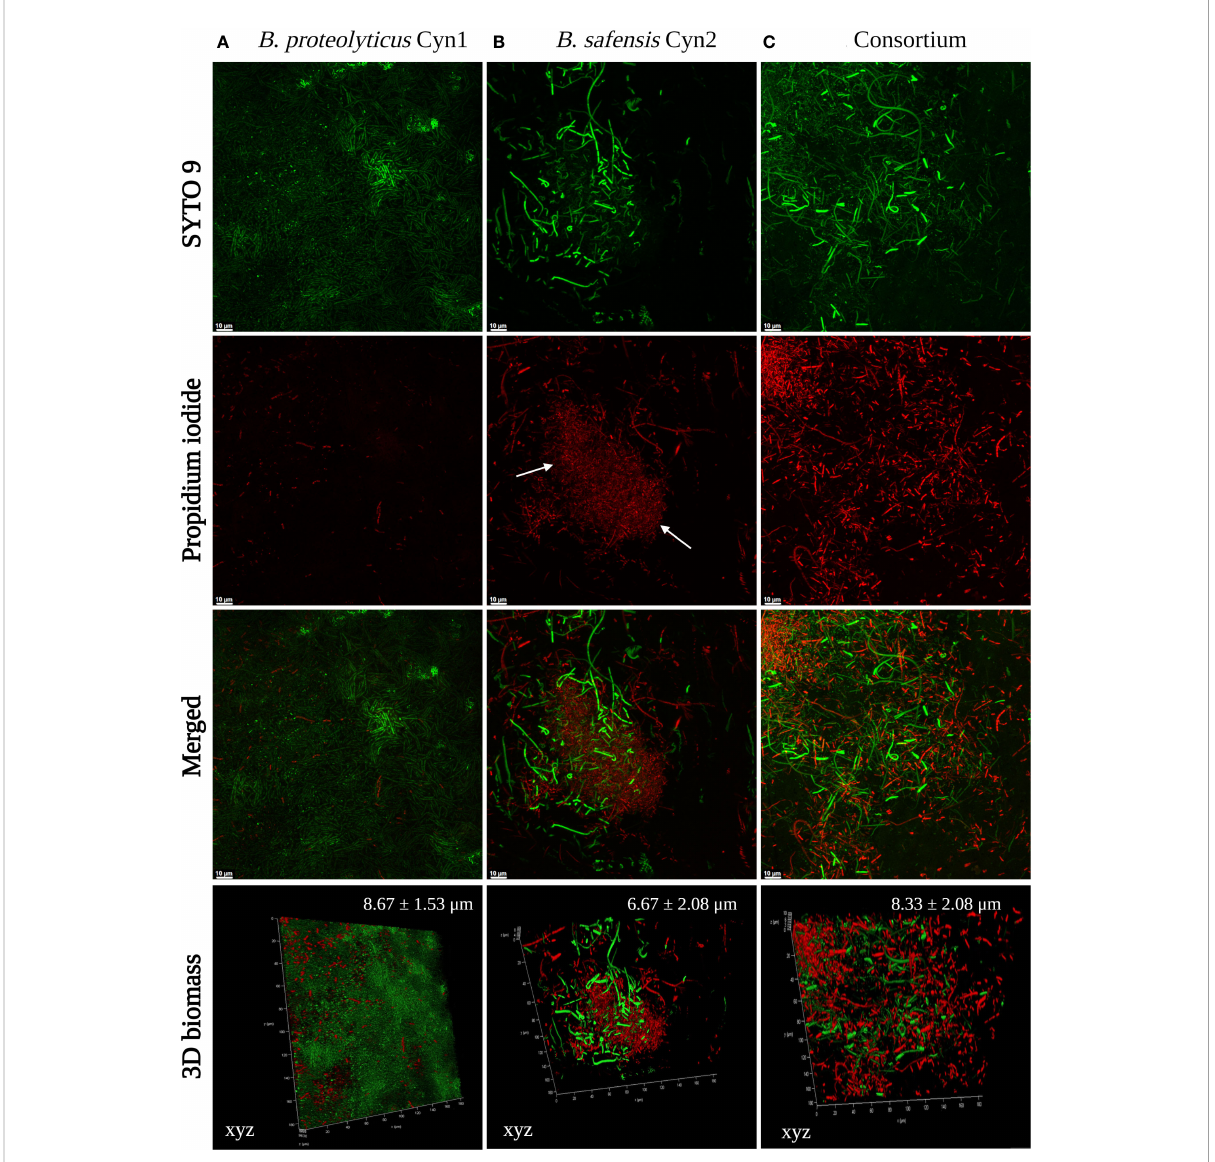
FIGURE 2 Confocal microscopy images of (A) B. proteolyticus Cyn1, (B) B. safensis Cyn2, and (C) consortium bio fi lms. Staining was done with SYTO 9/ propidium iodide (LIVE/DEAD BacLight Bacterial Viability kit), and images were acquired at 60 x magni fi cation. Only live cells internalize SYTO 9 ( fl uorescing green), whereas dead cells allow the uptake of PI ( fl uorescing red). In all panels, the results are representative images of three independent experiments and bio fi lm growth was evaluated at 96 h. Three-dimensional (3D) biomass of the bio fi lm for each set is also represented in the lower panels. The white arrows indicate the presence of